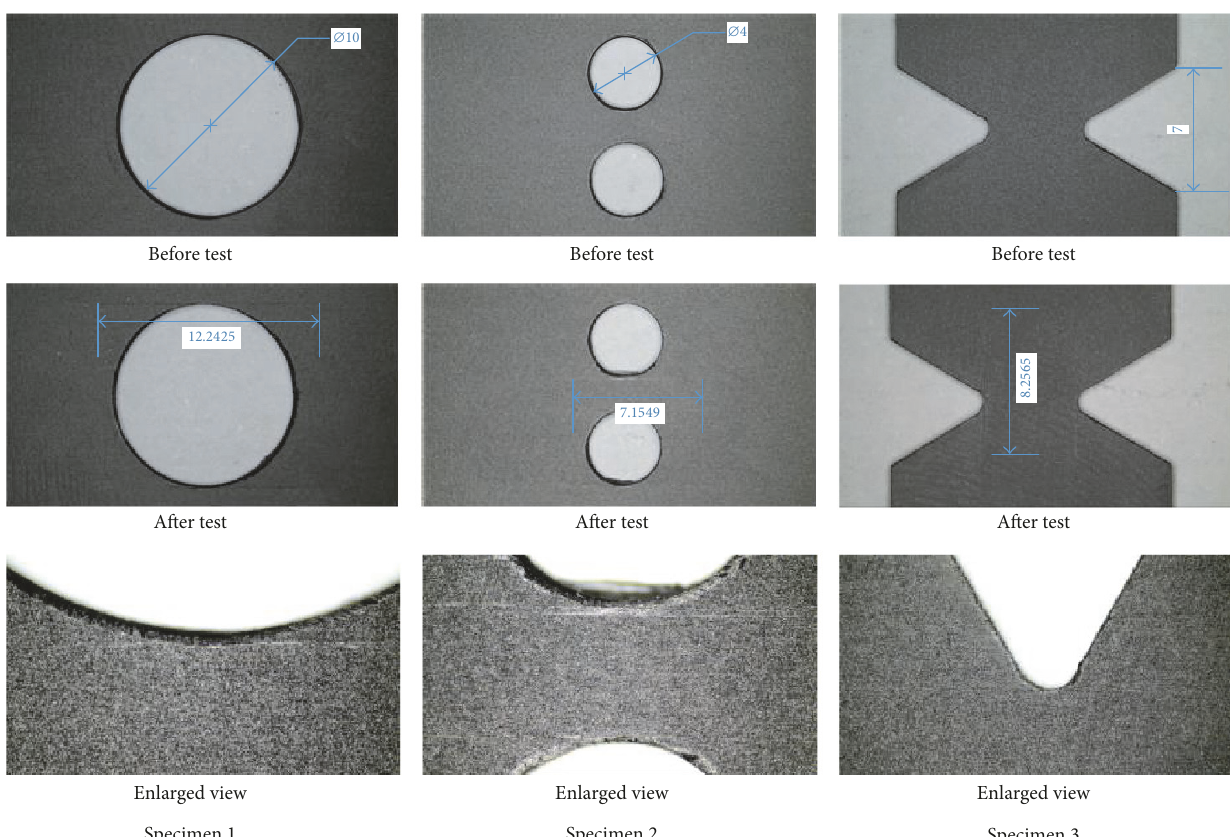
Figure 13: The vibration fatigue damage of different specimens.